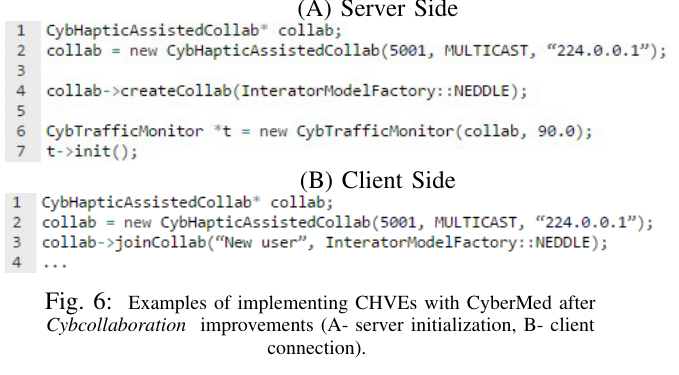
Fig. 6: Examples of implementing CHVEs with CyberMed after Cybcollaboration improvements (A- server initialization, B- client